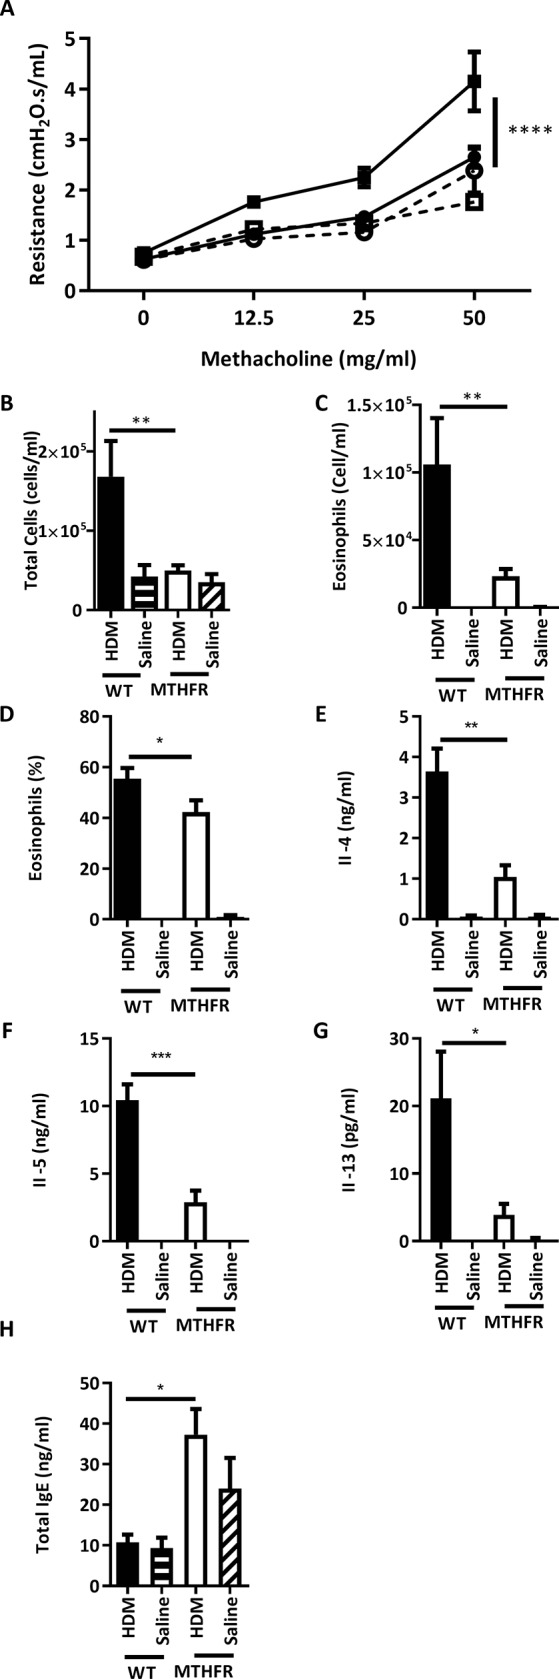
Allergic airway disease was suppressed in C57BL/6Mthfr-/- mice compared to C57BL/6 mice.Loss of Mthfr activity suppressed the severity of HDM-induced allergic airway disease with virtually no changes at baseline. (A) airway hyperresponsiveness (HDM-treated C57BL/6 solid line closed square, HDM-treated C57BL/6Mthfr-/- solid line closed circle, saline-treated C57BL/6 dashed line open square, and saline-treated C57BL/6Mthfr-/- dashed line open circle), (B) total cells in WLL, and (C) concentration of eosinophils, (D) percentage of eosinophils in the WLL, (E) WLL Il-4 cytokine levels, (F) WLL Il-5 cytokine levels, (G) WLL Il-13 cytokine levels, and (H) total IgE levels in the serum (HDM-treated C57BL/6 black bar, HDM-treated C57BL/6Mthfr-/- white bar, saline-treated C57BL/6 black bar with white dots, and saline-treated C57BL/6Mthfr-/- white bar with black dots, * p-value <0.05, ** p-value <0.01, *** p-value <0.001).